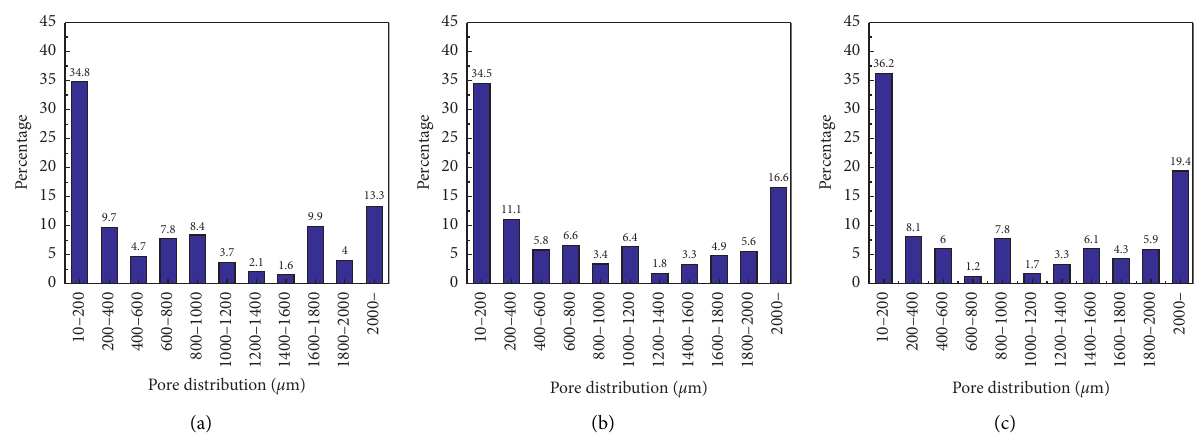
Figure 21: Pore size distribution of OC with different freeze-thaw cycles. (a) 0 times. (b) 50 times. (c) 125 times.